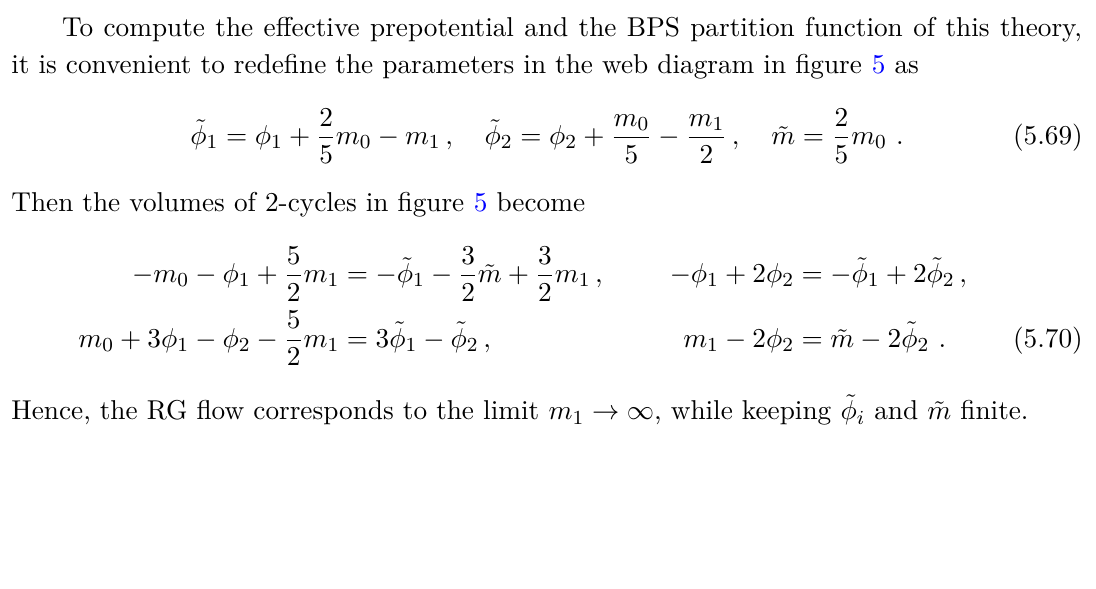
+ 1 Sym and Sp(2) π + 1 Adj , where a flop transition for the 3 / 2 m 1 is 2